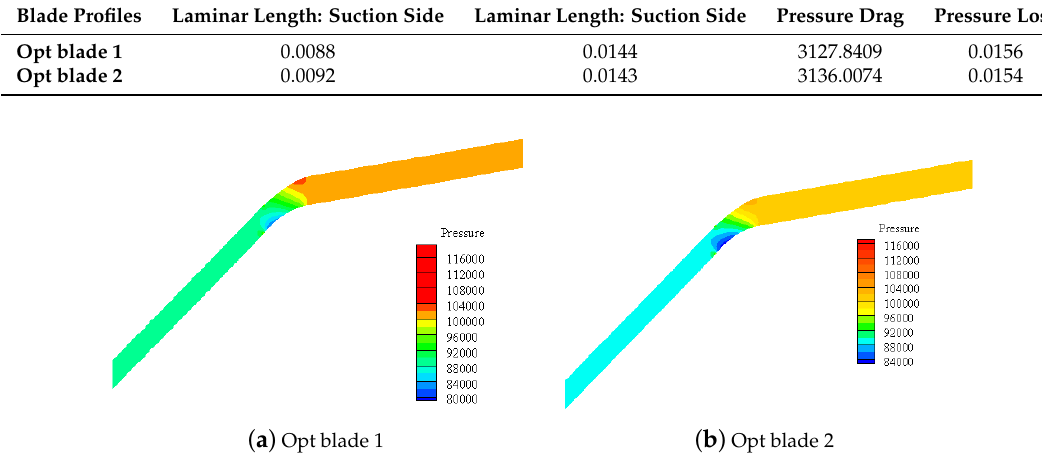
Figure 18. Global view of pressure contour in the domains of the two optimized